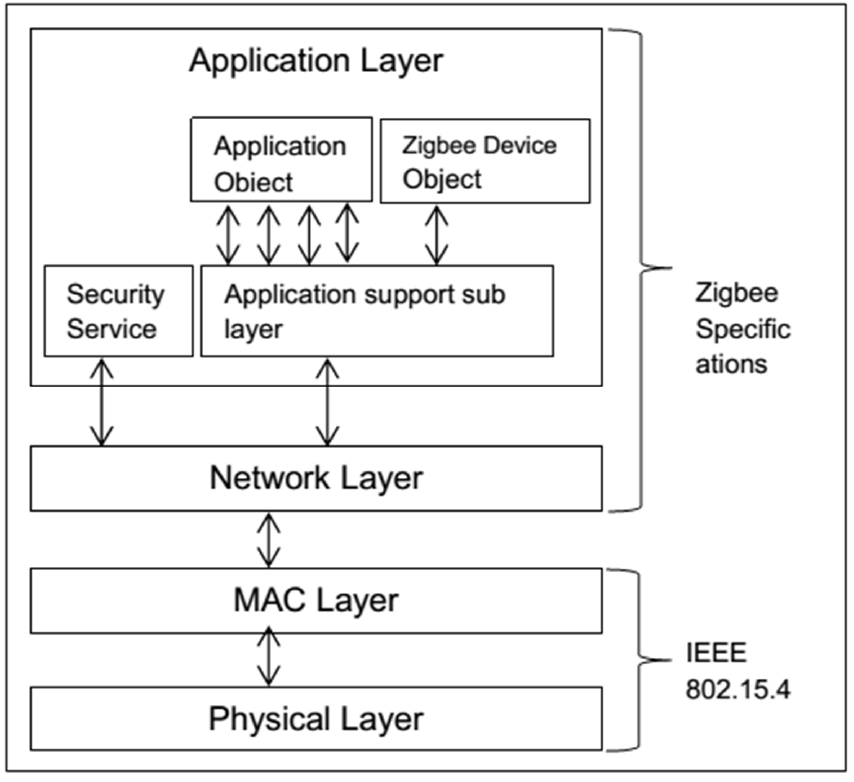
Figure 2. ZigBee protocol architecture [6].